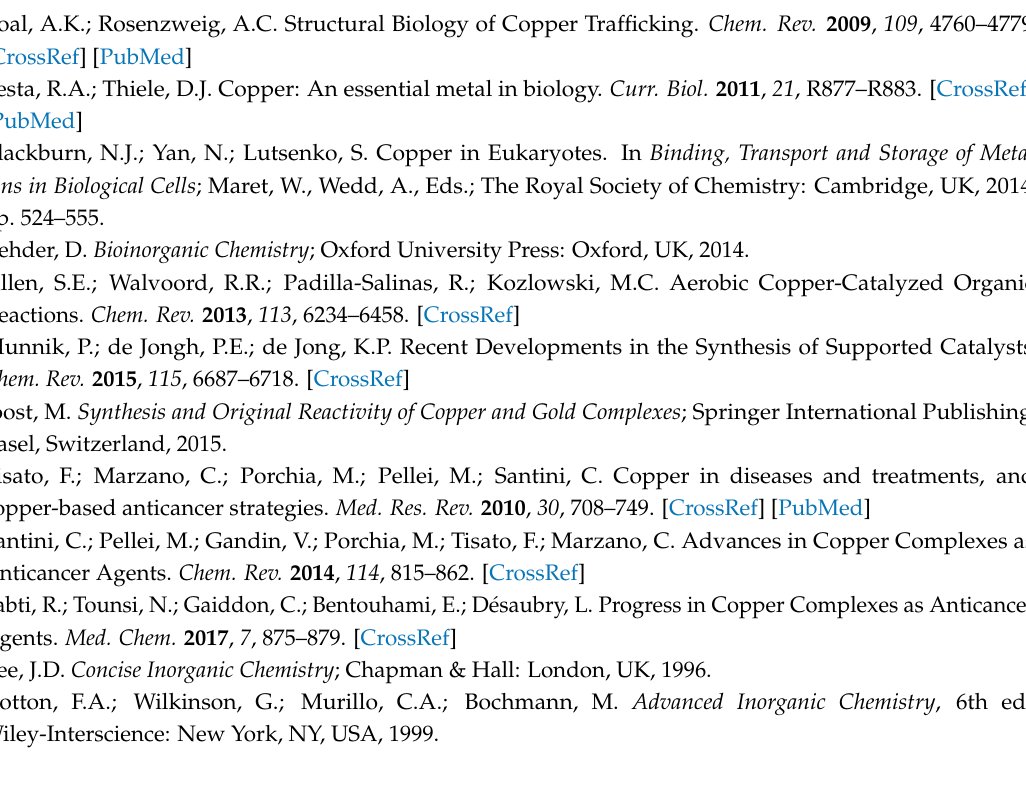
Table S1: Values of A x , A y , A z and g z for the fourteen Cu(II) complexes examined, Tables S2–S12: Values of A iso , A x , A y , A z and g z and percent deviation (PD) calculated at the level of theory Functional/6-311g(d.p), Table S13: Selected bond distances and angles for the models of HSA and PrP, Figures S1–S5: Superimposition of the experimental and optimized structures of [Cu(bipy) 2 (NCS)] + , [Cu(ttcn)] 2+ , [Cu( S , S -mnpala)], [CuH –2 GGH] − and [Cu(mnt)] 2 − , Cartesian coordinates of the fourteen Cu(II) complexes generated by EsiGen